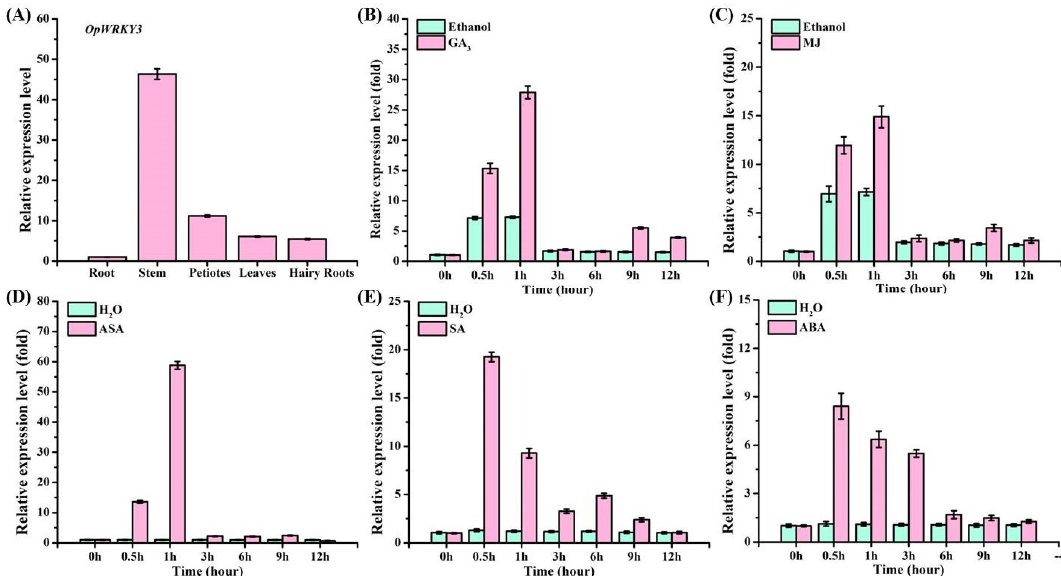
Figure 2. The expression pattern of OpWRKY3 . ( A ) Expression pattern of OpWRKY3 in different tissues. Transcript abundance of OpWRKY3 is normalized to actin by the method of 2 −ΔΔCt . ( B ) Time course of the expression level of OpWRKY3 after gibberellin (GA 3 ) treatment as determined by qRT-PCR. ( C ) The expression level of OpWRKY3 after methyl jasmonate (MJ) treatment for selected time points measured by qRT-PCR. ( D ) The expression level of OpWRKY3 after acetylsalicylic acid (ASA) treatment for selected points by qRT-PCR analysis. ( E ) Time course of the expression level of OpWRKY3 after salicylic acid (SA) treatment as determined by qRT-PCR. ( F ) The expression level of OpWRKY3 after abscisic acid (ABA) treatment for selected time points measured by qRT-PCR, respectively. Values are means ± standard deviation of triplicate analyses.